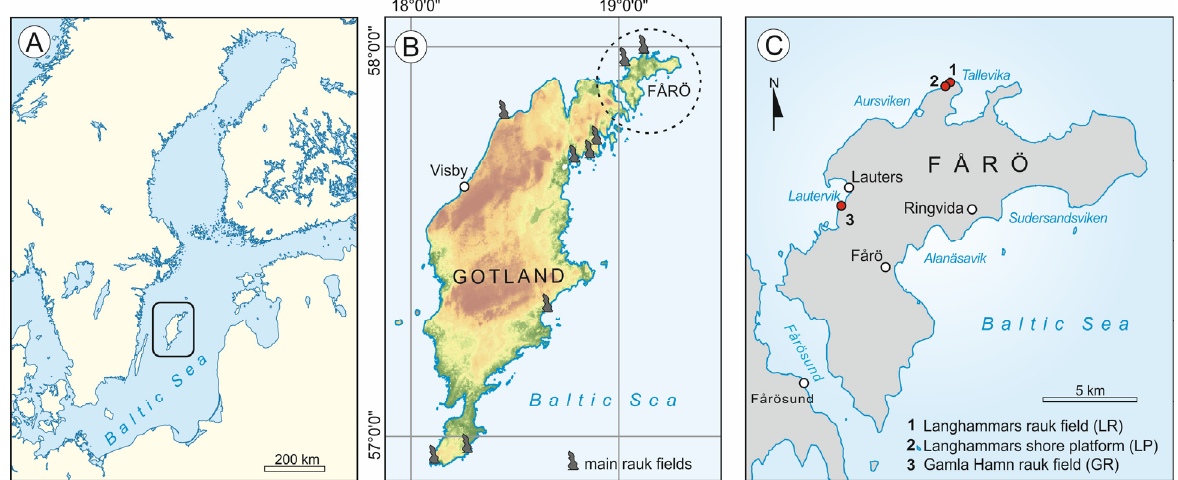
Figure 1. Location of study area: ( A ) Gotland and Fårö on the Baltic Sea; ( B ) main rauk fields in Gotland and Fårö; ( C ) location of TLS measurement sites on Fårö.